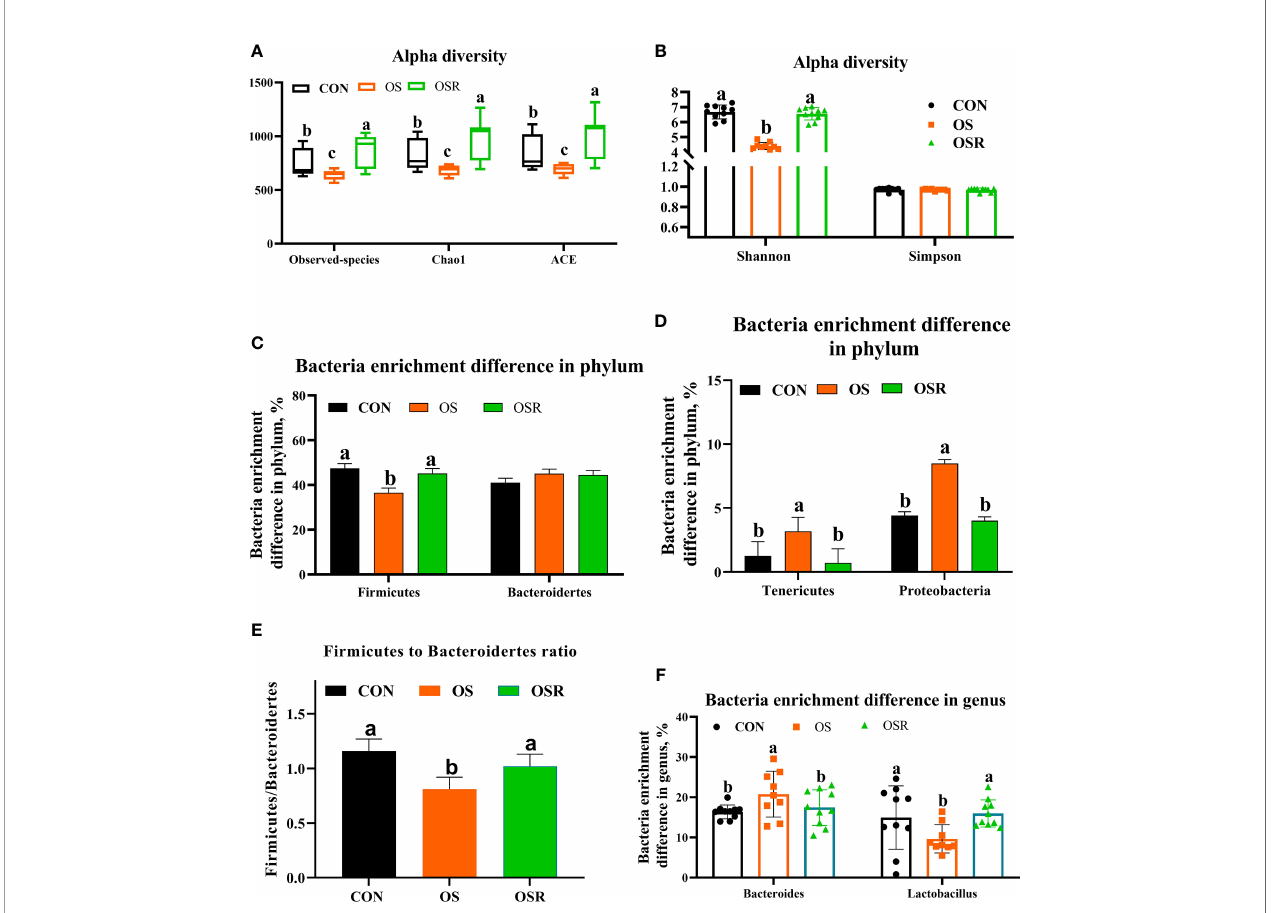
FIGURE 5 | Dietary resveratrol supplementation alleviated the oxidative stress (by tBHP) induced reduction in cecal bacteria diversity and enrichment (Exp.1). (A, B) Alpha diversity of cecum microbiota, with observed species, Chao1, ACE (A) , and Shannon and Simpson index (B) . (C-E) Bacteria enrichment difference in phylum. (F) Bacteria enrichment difference in genus. Data are means ± SEM represented by vertical bars or plot individual values ± SEM. Statistical signi fi cance was evaluated by Tukey ’ s Test, p <